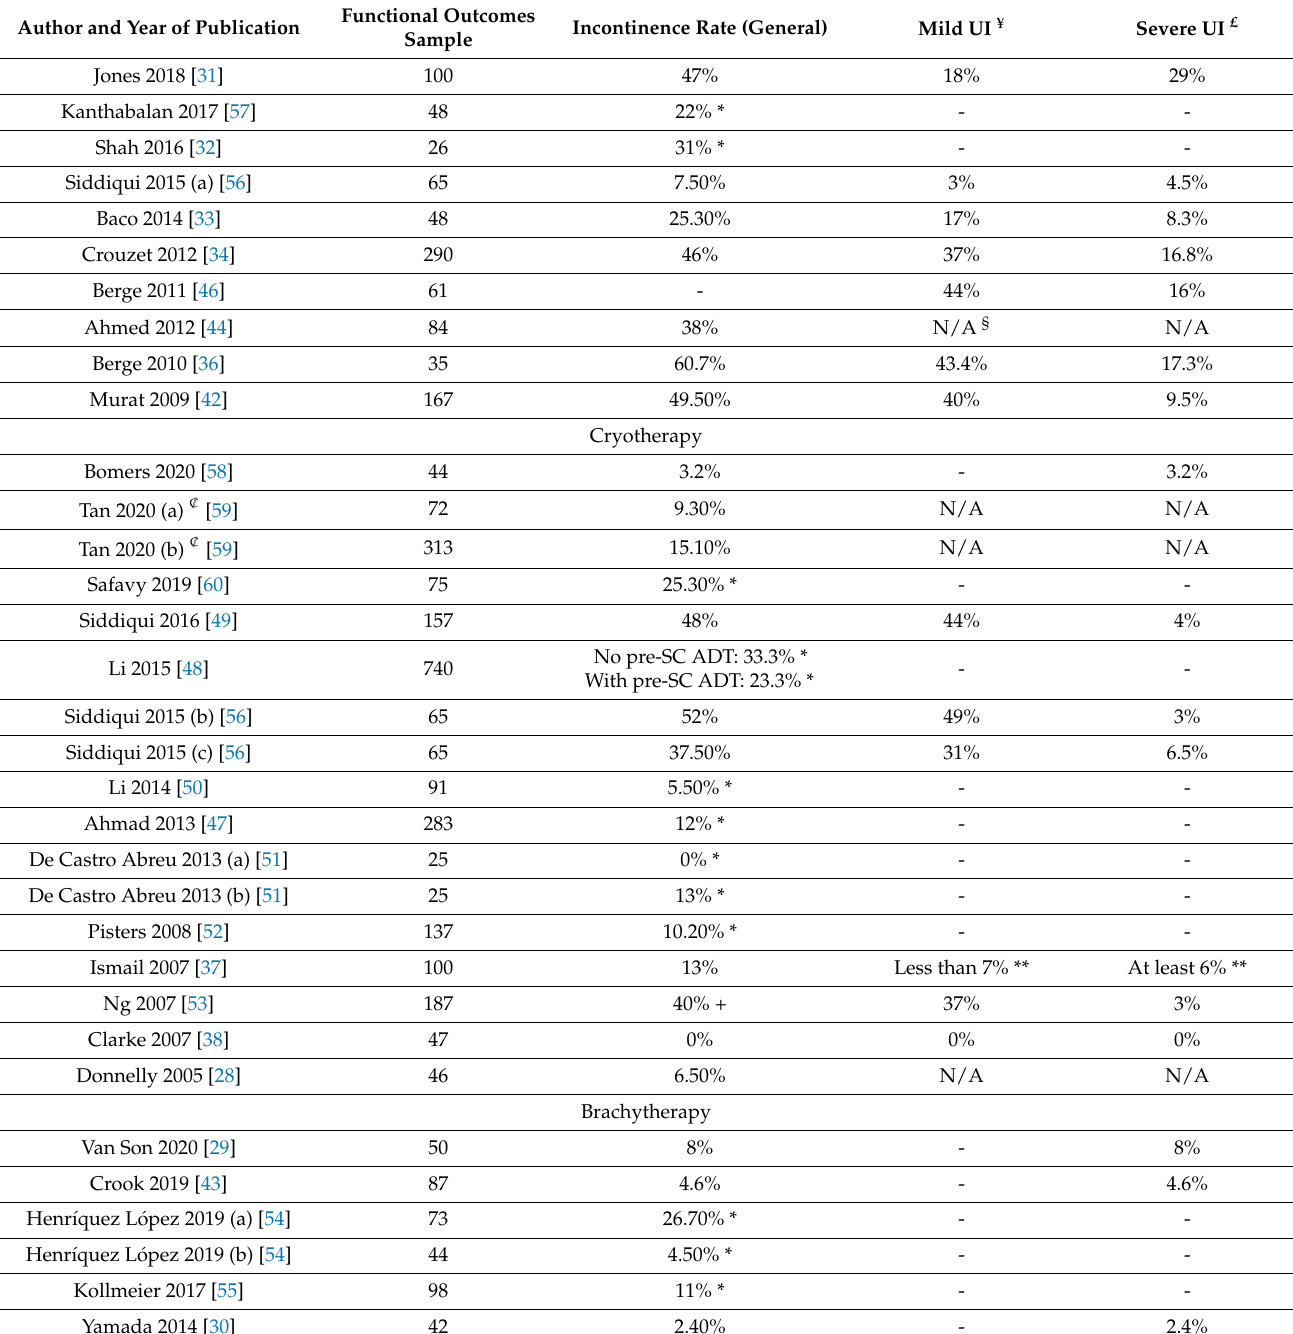
Table 2. Urinary function outcomes after various salvage interventions presented as mild versus severe urinary inconti- nence.